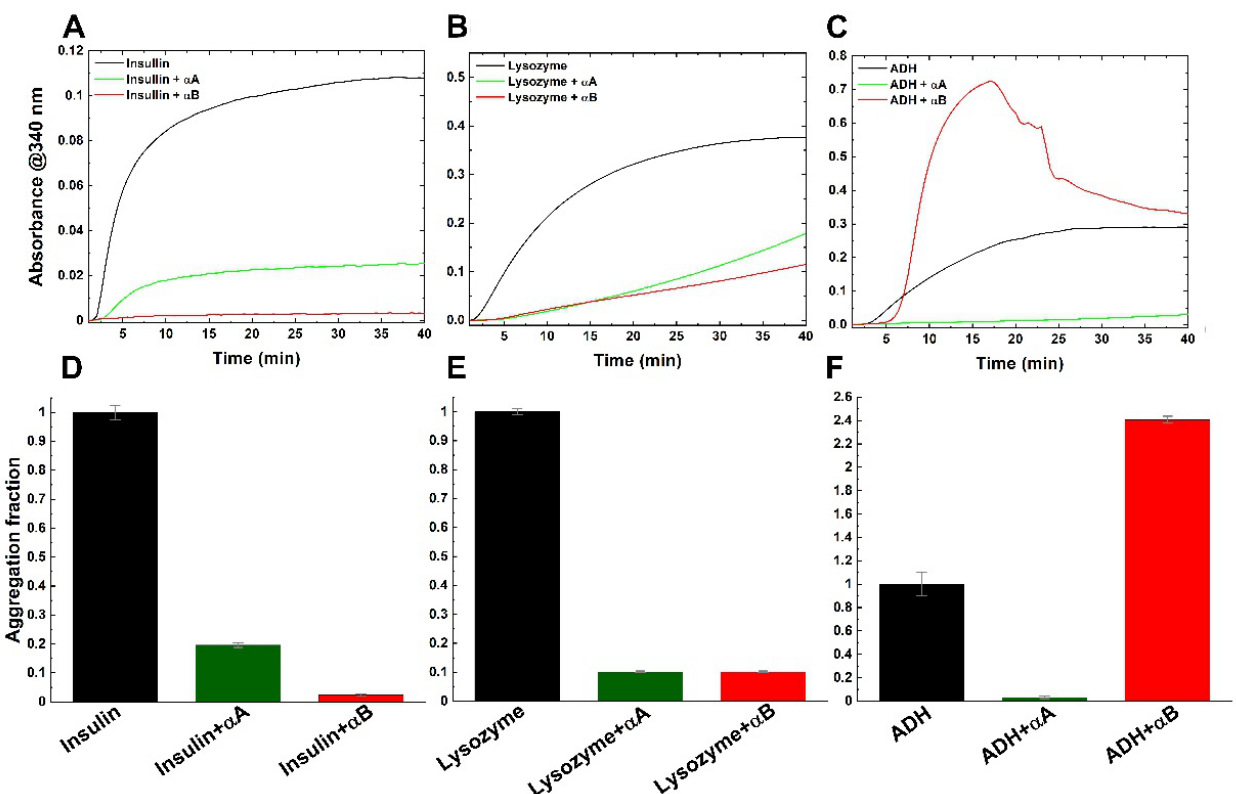
Figure 3. Chaperone-like activity of α -crystallins for the chemical- and heat-induced aggregation of target proteins. Assays were performed at 37 °C for insulin and lysozyme and 55 °C for alcohol dehydrogenase, ADH. Curves indicate the aggregation of insulin ( A ), lysozyme ( B ) or ADH ( C ) alone or with α A or α B crystallin. Chaperone activity was represented as aggregation fraction ( D – F ). Assays were performed in triplicate and the bars represent the mean ± SD.